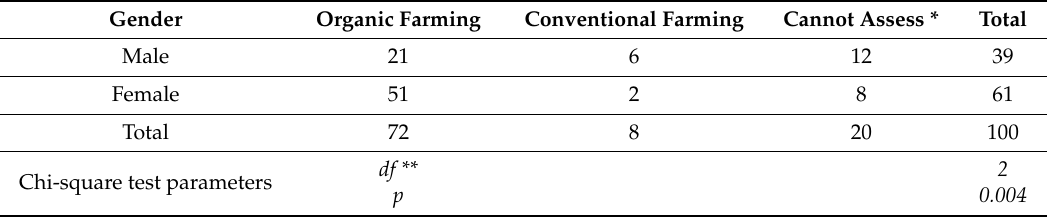
Table 4. Description of gender and responses on sustainable farming